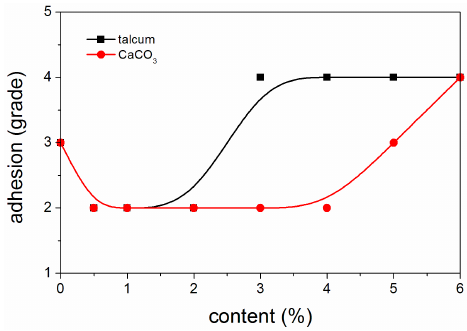
Figure 8. Effect of single filler on adhesion of coating (samples 5, 11–24 in Table 1).